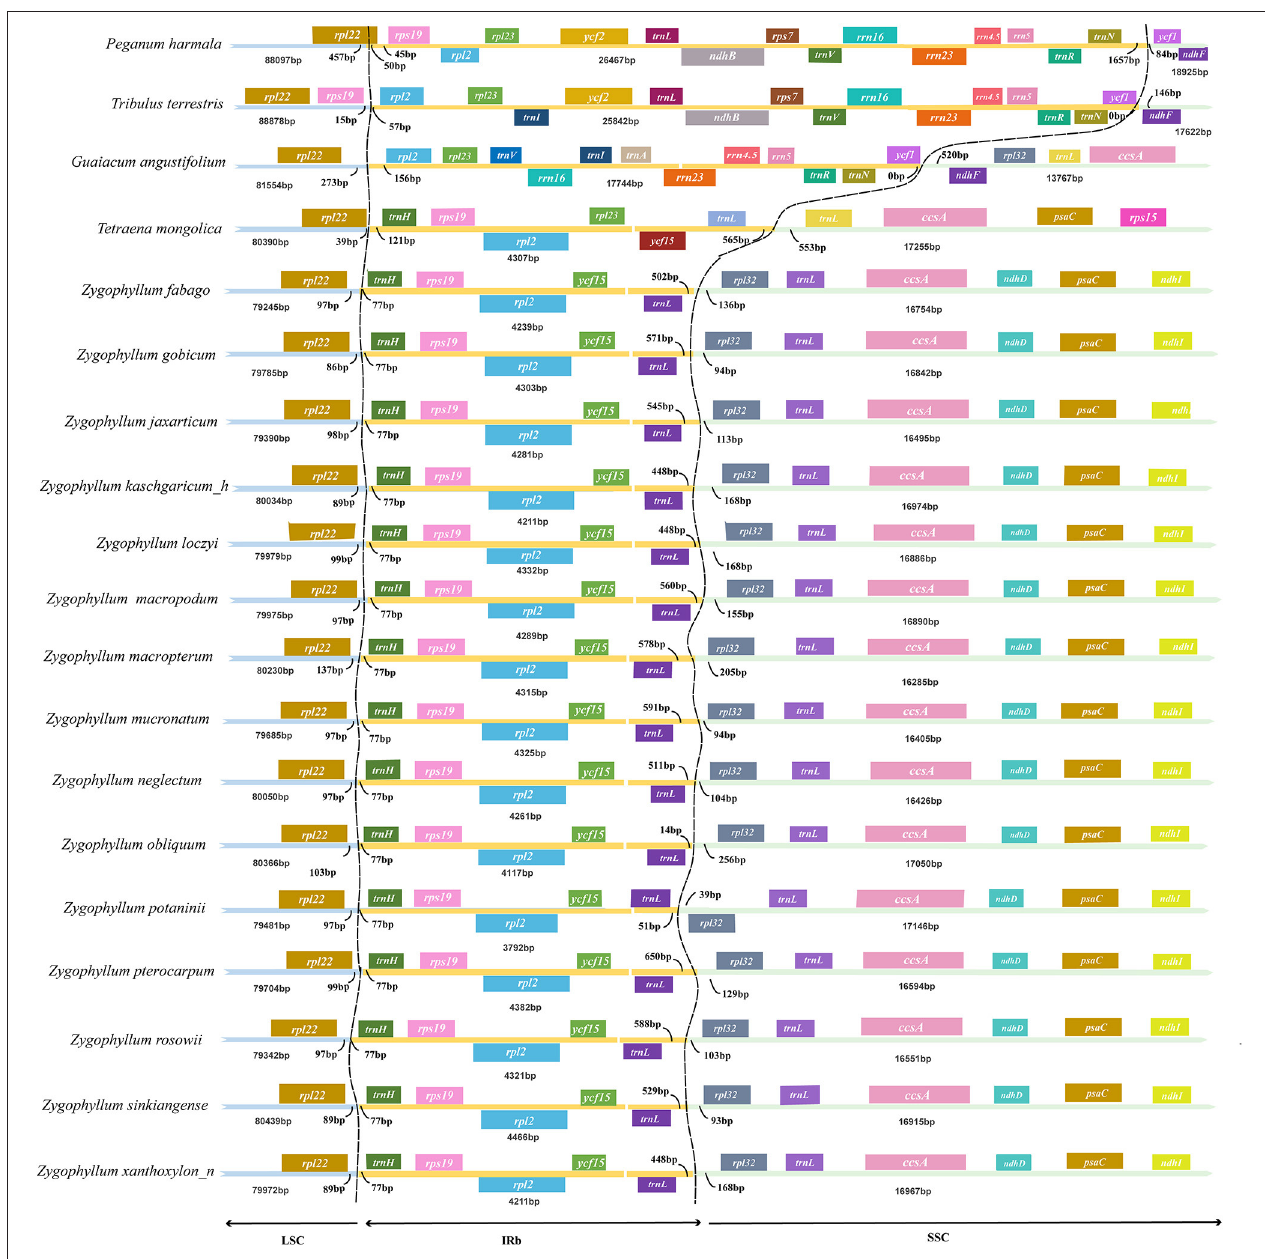
FIGURE 1 | Comparison of large single-copy (LSC), small single-copy (SSC), and inverted repeat (IR) borders among plastomes of Zygophyllaceae.